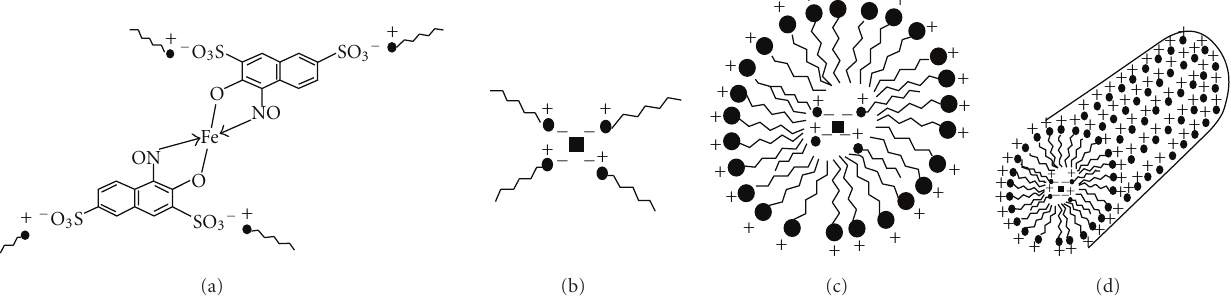
Figure 2: Schematic representation of metal-ligand complex at di ff erent stages in the presence of cationic surfactant. (a) Neutralized complex in bulk solution, (b) symbolic representation of electrostatically neutralized complex, (c) incorporation of metal-ligand complex into the hydrophobic core of micelle, and (d) agglomeration of the complex entrapped micelles to form the tubular or rod-like structures.